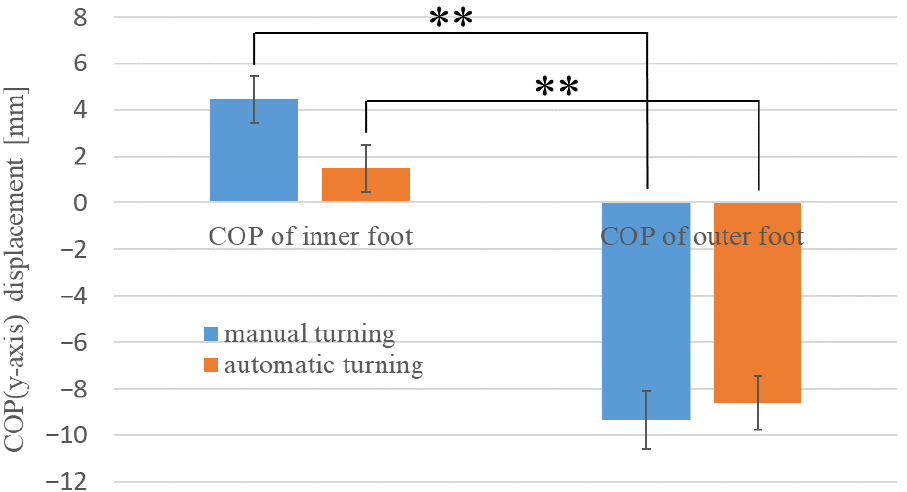
Figure 11. Average of COP ( y -axis) during